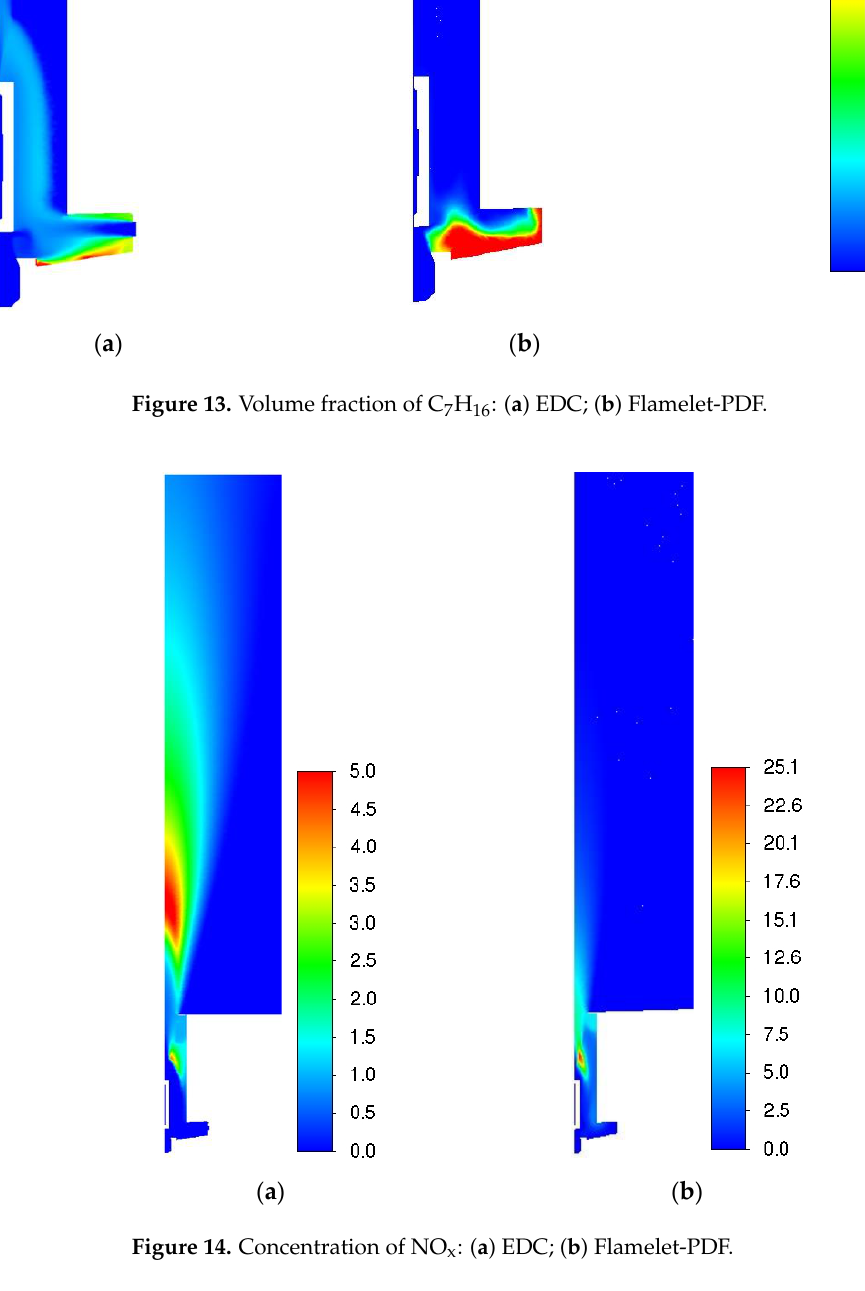
Figure 14. Concentration of NO x : ( a ) EDC; ( b ) Flamelet-PDF.